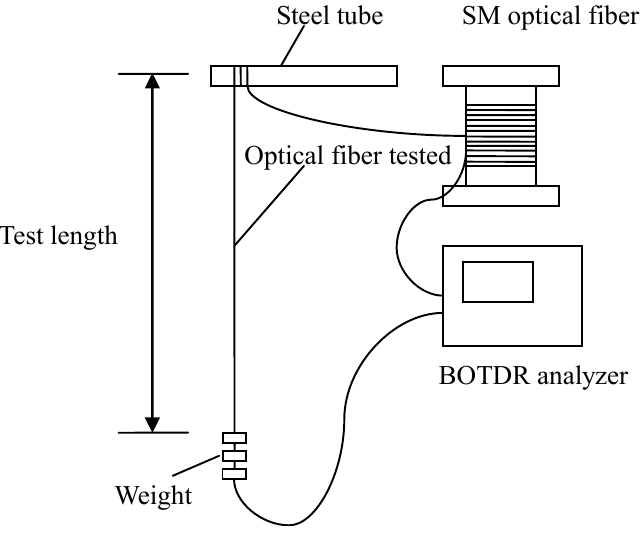
Figure 2. Setup of the strain calibration